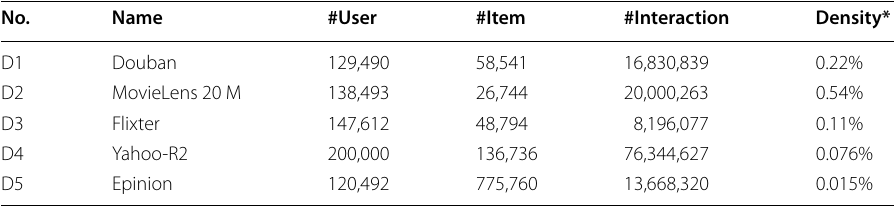
* Density denotes the percentage of observed entries in the dataset